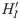
Interventions targeting vector survival, such as insecticide spraying, increase the likelihood of immune pre-sensitisation through pre-exposure to vector saliva.Shown are the equilibrium abundances in the ODE model of (a) susceptible (VS; blue), exposed (VE; purple) and infectious (VI; red) vectors, and (b) infected hosts that are not pre-exposed (HI; red) and that are pre-exposed (HI′; pink) to vector saliva. Here, the x-axis is the daily rate of vector mortality imposed by vector control. Pre-sensitised and naïve infected hosts are assumed to have identical recovery rates (γH = γH′ = 60−1 per day) and transmission probabilities (THV = TH′V = TVH = TVH′ = 0.5). Note that the force of infection from vectors, rTHVVI, is proportional to the abundance of infectious vectors, and the rate of immune pre-sensitisation through vector saliva pre-exposure, rPHV(VS + VE + (1 − THV)VI), is roughly proportional to the abundance of susceptible vectors (notice that VS is at least one order of magnitude larger than VE or VI).